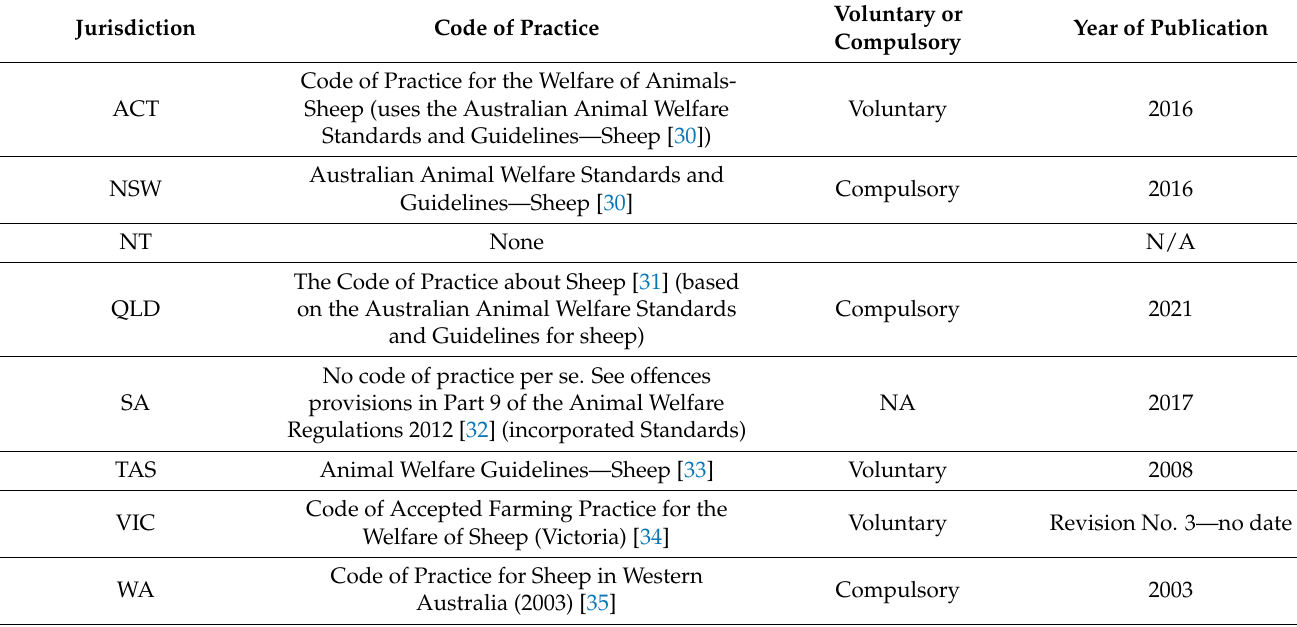
Table 1. State Codes of Practice for sheep and year of